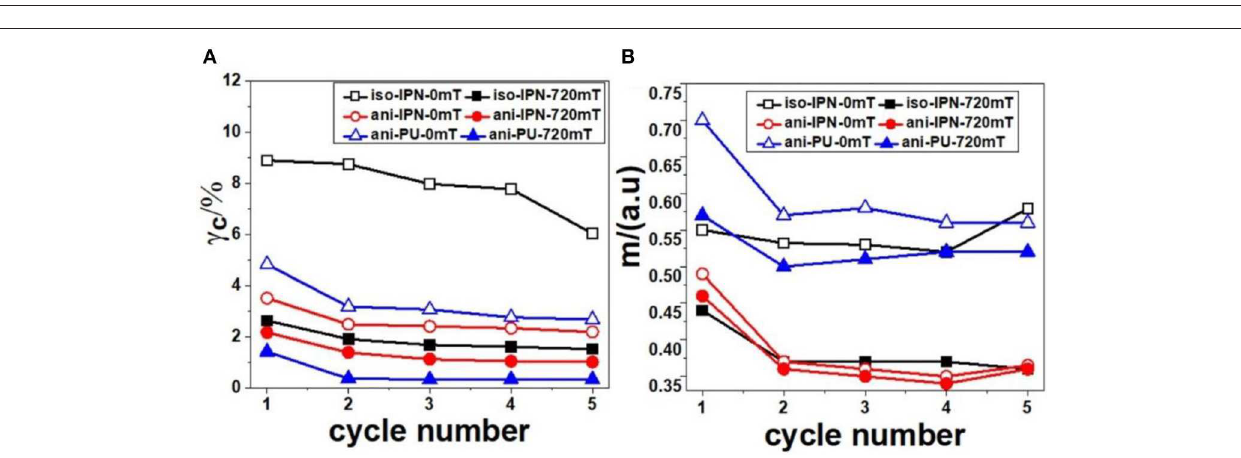
FIGURE 8 | Cycle number dependence of the G ′ 0 (A) and G ′ ∞ (B) . The hollow symbol and solid symbol indicated the tests under 0 and 720 mT, respectively.